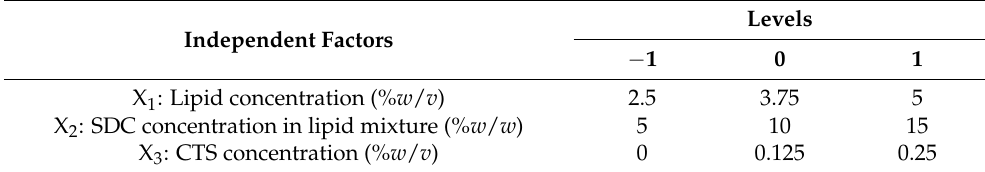
Table 1. The independent factor levels used for BER-CTS-BLS optimization. Independent